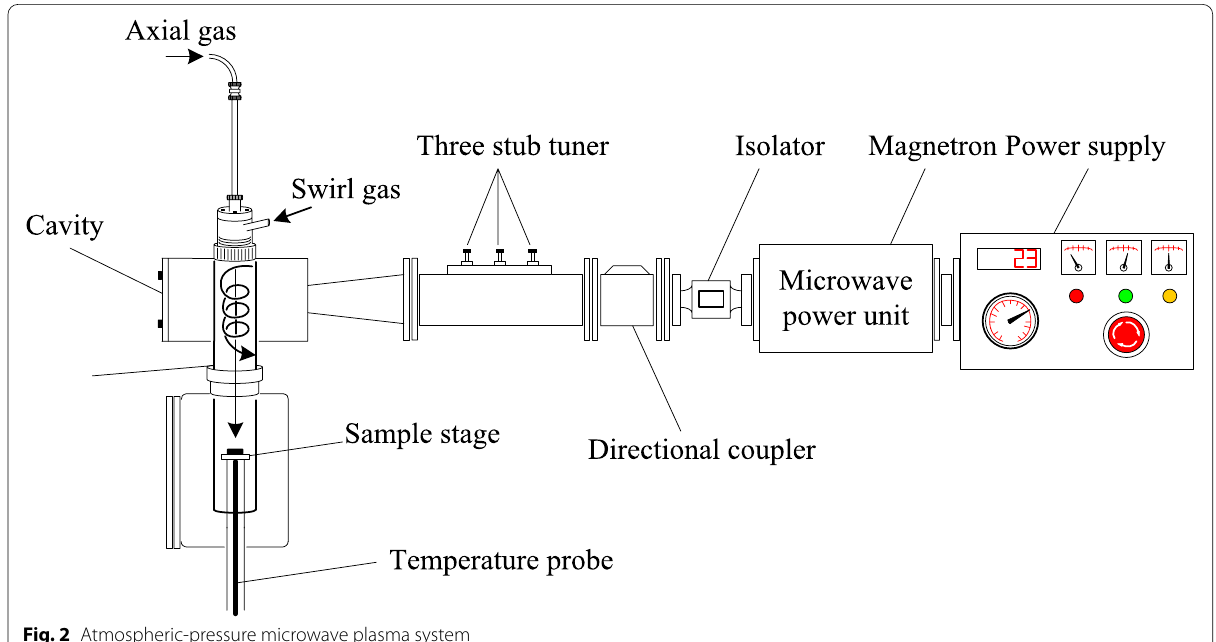
Fig. 2 Atmospheric‑pressure microwave plasma